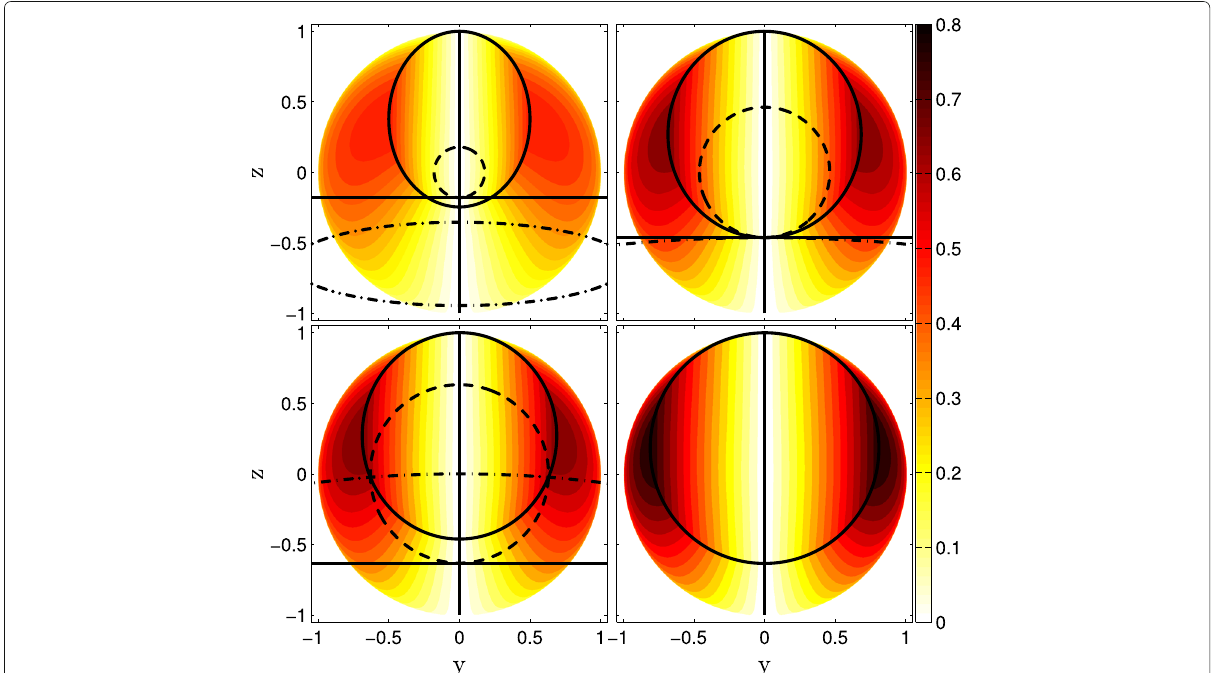
Fig. 5 (Color online) Figure of merit surface Q ( y m , z m ) associated with the steady-state syntheses of Fig. 4. The solid, dashed and dot-dashed lines represent the boundaries between the different regions of the Bloch ball where the control law is not the same. The definition of these lines is given in Fig.